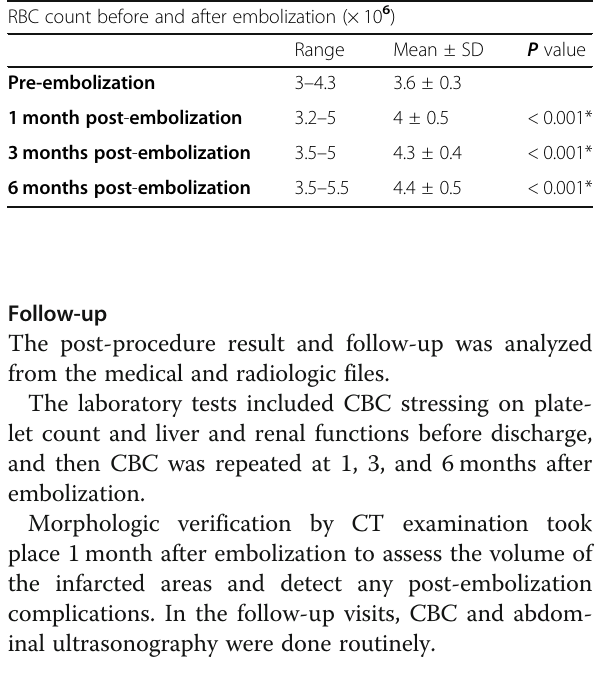
Table 2 Pre-embolization relevant US findings